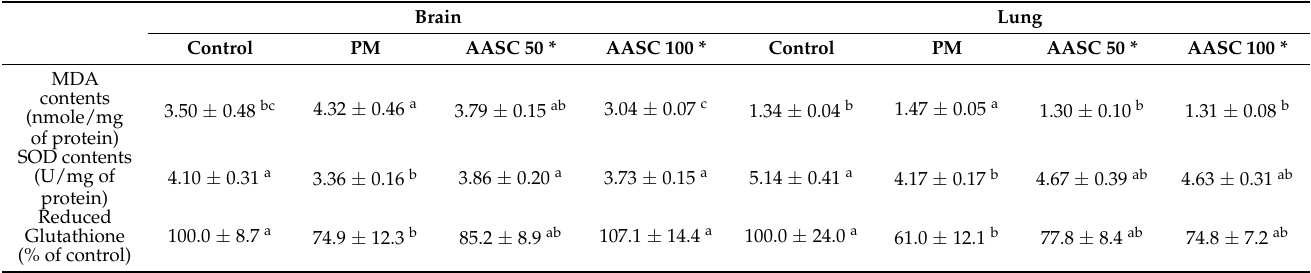
Table 3. Effect of AASC on biochemicals related to oxidative stress in the brain and lung tissues of mice exposed to PM 2.5